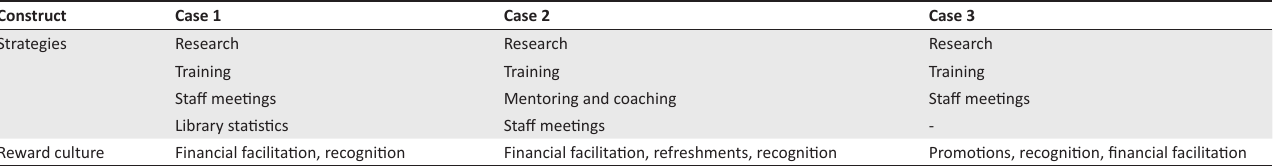
TABLE 2: Reward culture and knowledge creation strategies.